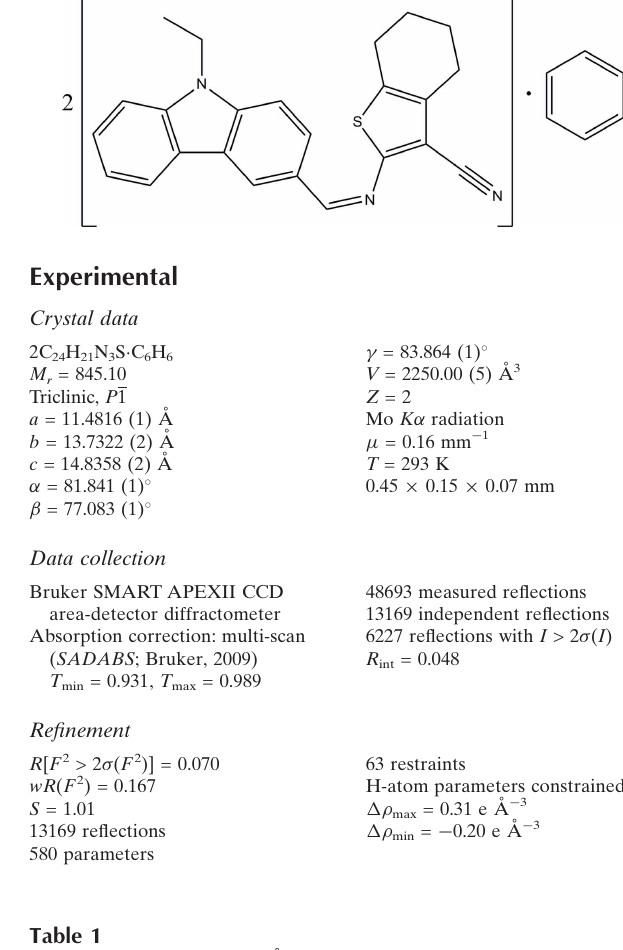
Hydrogen-bond geometry (A˚ , (cid:3)